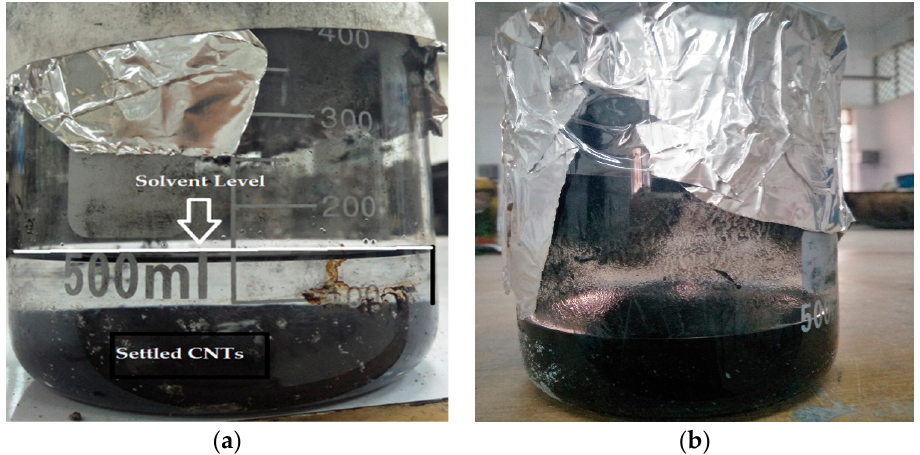
Figure 3. ( a ) CNTs in solvent before sonication; and ( b ) CNTs in solvent after sonication and stirring.